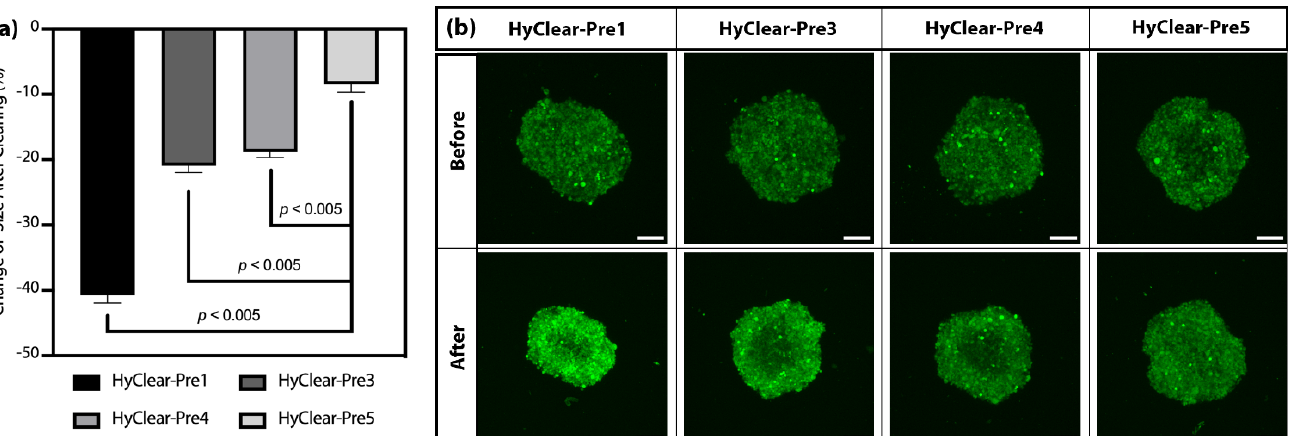
Figure 4. ( a ) The average fold increase in the fluorescence signal after clearing using different types of HPG. ( b ) The average change of the area of the cross-sectional images before and after clearing using different types of HPG. ( c ) An example of the MIP image of the spheroids before and after tissue clearing using different types of HPG. The error bars represent the standard error of the mean of five to six replicates.